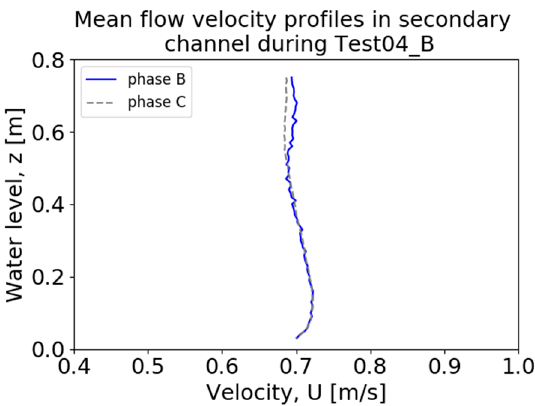
Figure 13. Mean profile velocity from Aquadopp measurements during current stabilization (phase B) and wave generation phase (phase C) of Test 04_B over the water column.